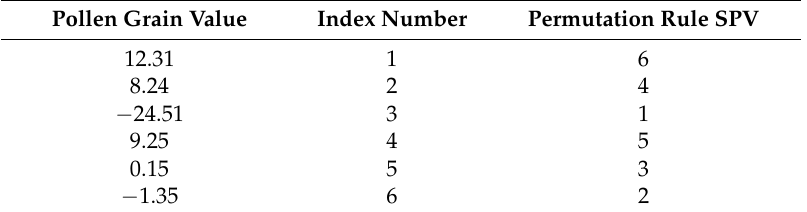
Table 4. Example of the transformation of a continuous representation of pollen grains to permutation representation